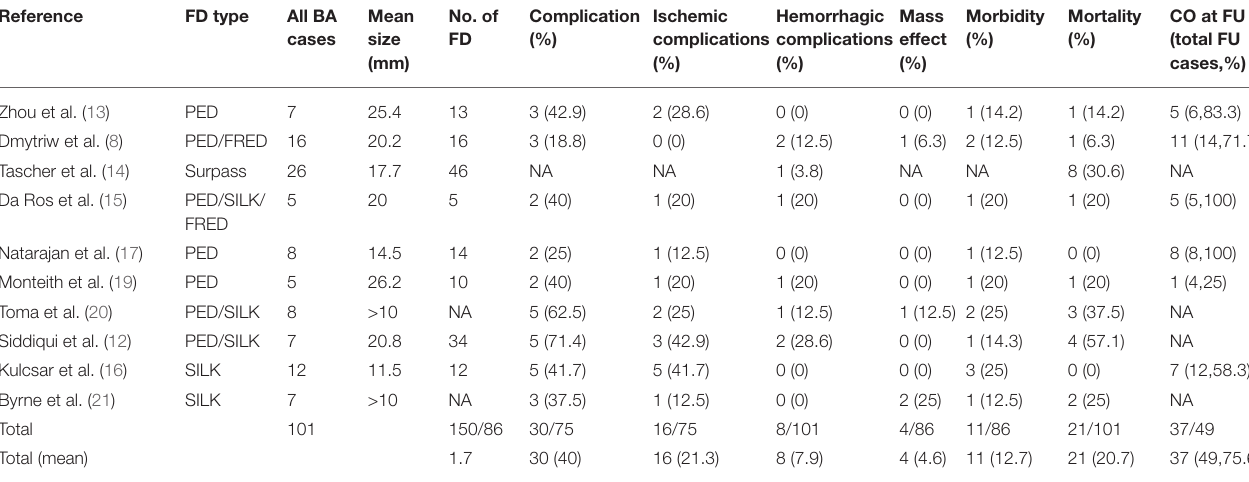
TABLE 4 | Summary of large series ( > 5 patients) reporting flow diverter treatment of basilar artery aneurysms.